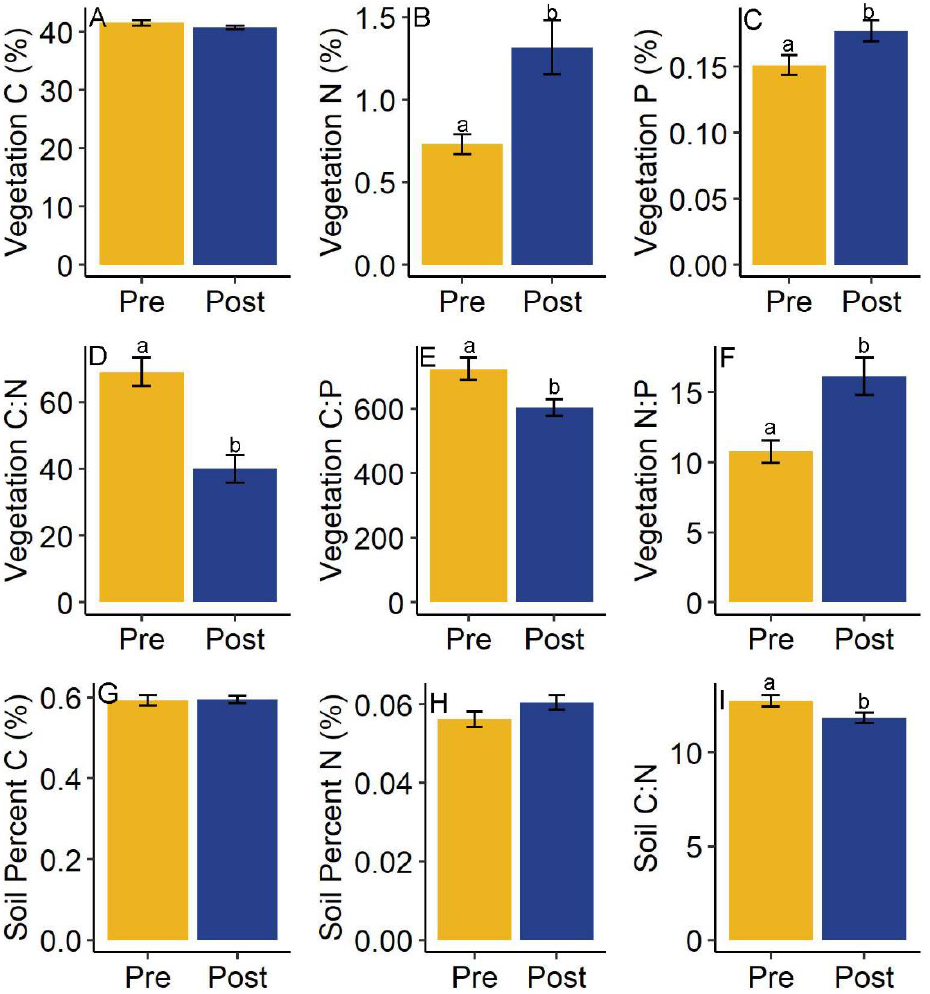
Figure 4. Aboveground vegetation and soil nutrient content by sampling period. Panels ( A – F ) represent nutrient content and stoichiometry for vegetation. Panels ( G – I ) show soil nutrient content and stoichiometry differences between sampling periods for all drainages. Significant differences are indicated by lowercase letters, and bars are the means across drainages, with error bars representing the standard error of the mean.